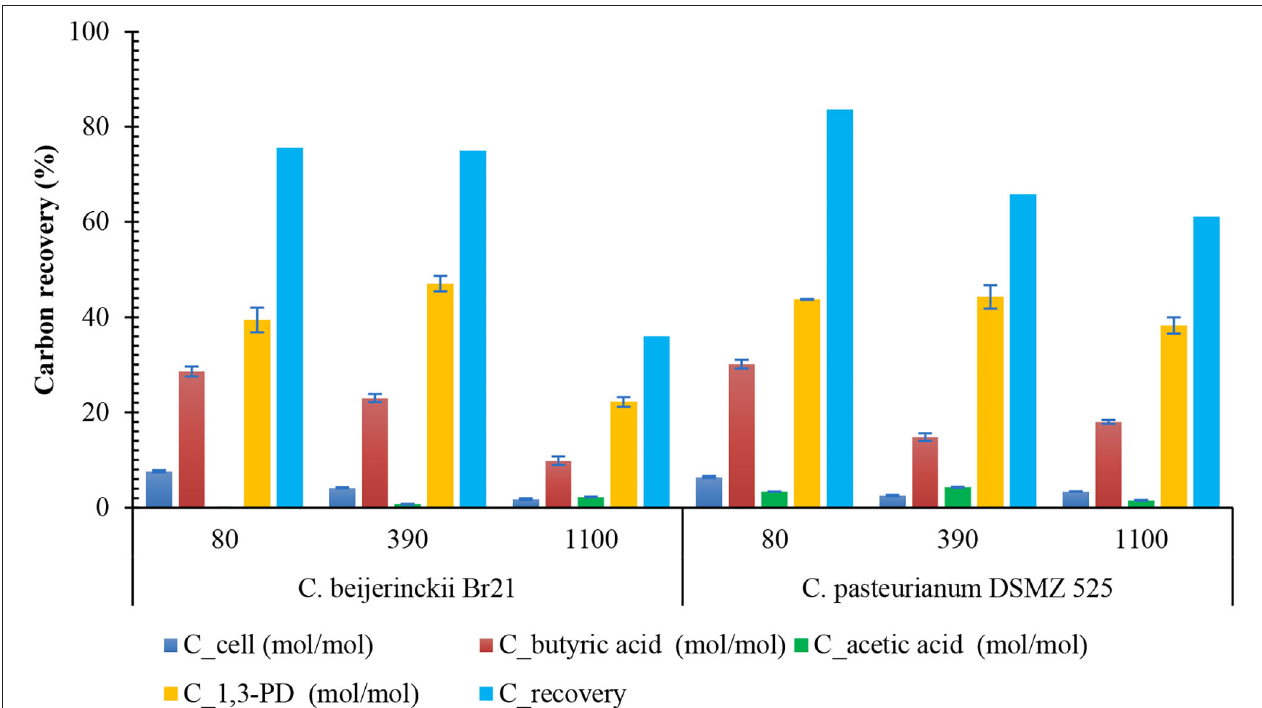
FIGURE 3 | Carbon balance of fermentations with initial glycerol concentrations of 80, 390, or 1,100mM by C. beijerinckii Br21 and C. pasteurianum DMSZ 525. Cell mass was considered as C 4 H 7 O 2 N ( Biebl, 2001).